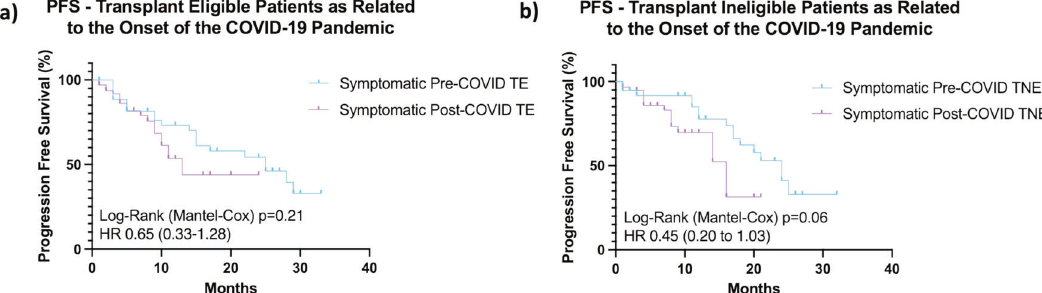
Fig. 6 Kaplan-Meier estimates of progression-free survival (PFS) in patients with symptomatic MM as related to the onset of the COVID- 19 pandemic. a Kaplan-Meier estimate of progression-free survival (PFS) in patients with symptomatic MM deemed fi t for therapy and transplant eligible ( n = 128) pre- and post-pandemic. Patients diagnosed 1st January 2019 – 31st January 2020 (Pre-COVID, n = 45) and from 1st February 2020 – 31st July 2021 (Post-COVID, n = 83). b Kaplan-Meier estimate of progression-free survival (PFS) in patients with symptomatic MM deemed fi t for therapy, but transplant ineligible( n = 118). Patients diagnosed 1st January 2019 – 31st January 2020 (Pre-COVID, n = 41) and from 1st February 2020 – 31st July 2021 (Post-COVID, n = 77). PFS progression-free survival, TE transplant eligible, TNE transplant